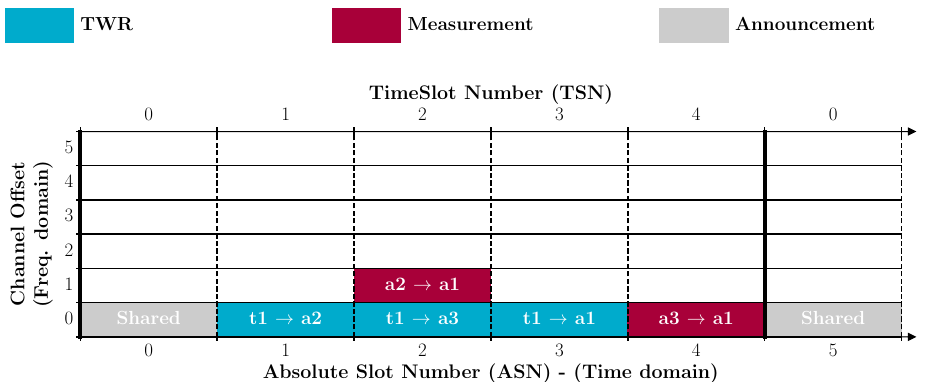
Figure 3. Schedule corresponding to the example of Figure 1. The slotframe contains 5 timeslots and repeats over